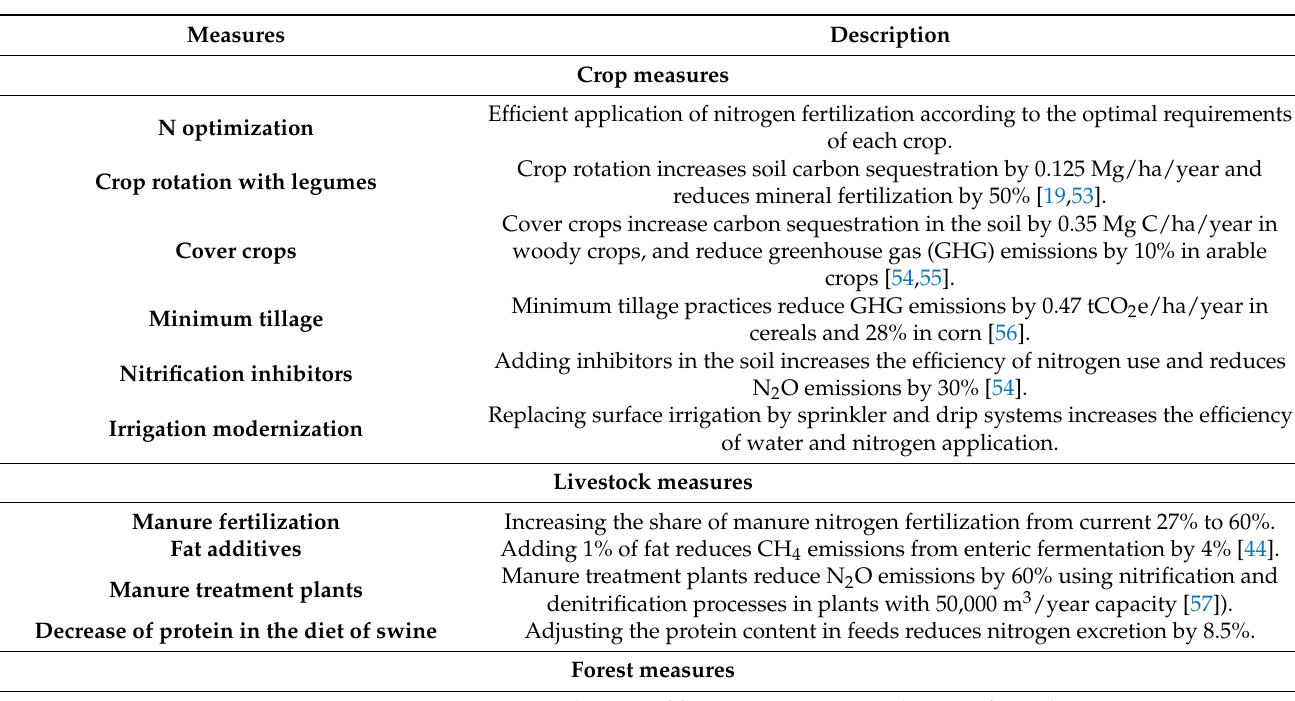
Table 1. Description of selected